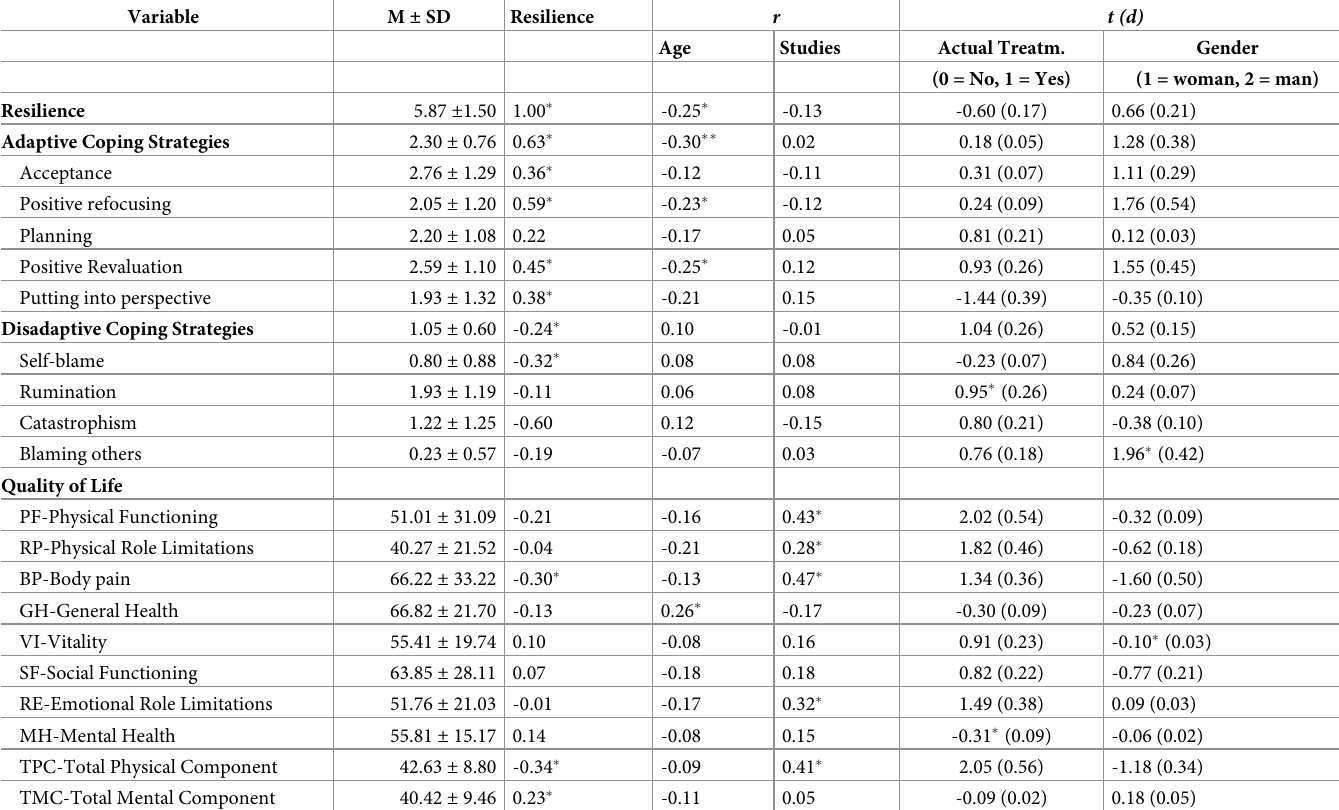
M = mean, SD = standard deviation, r = Pearson correlation coefficient, t = t -Student. � p <